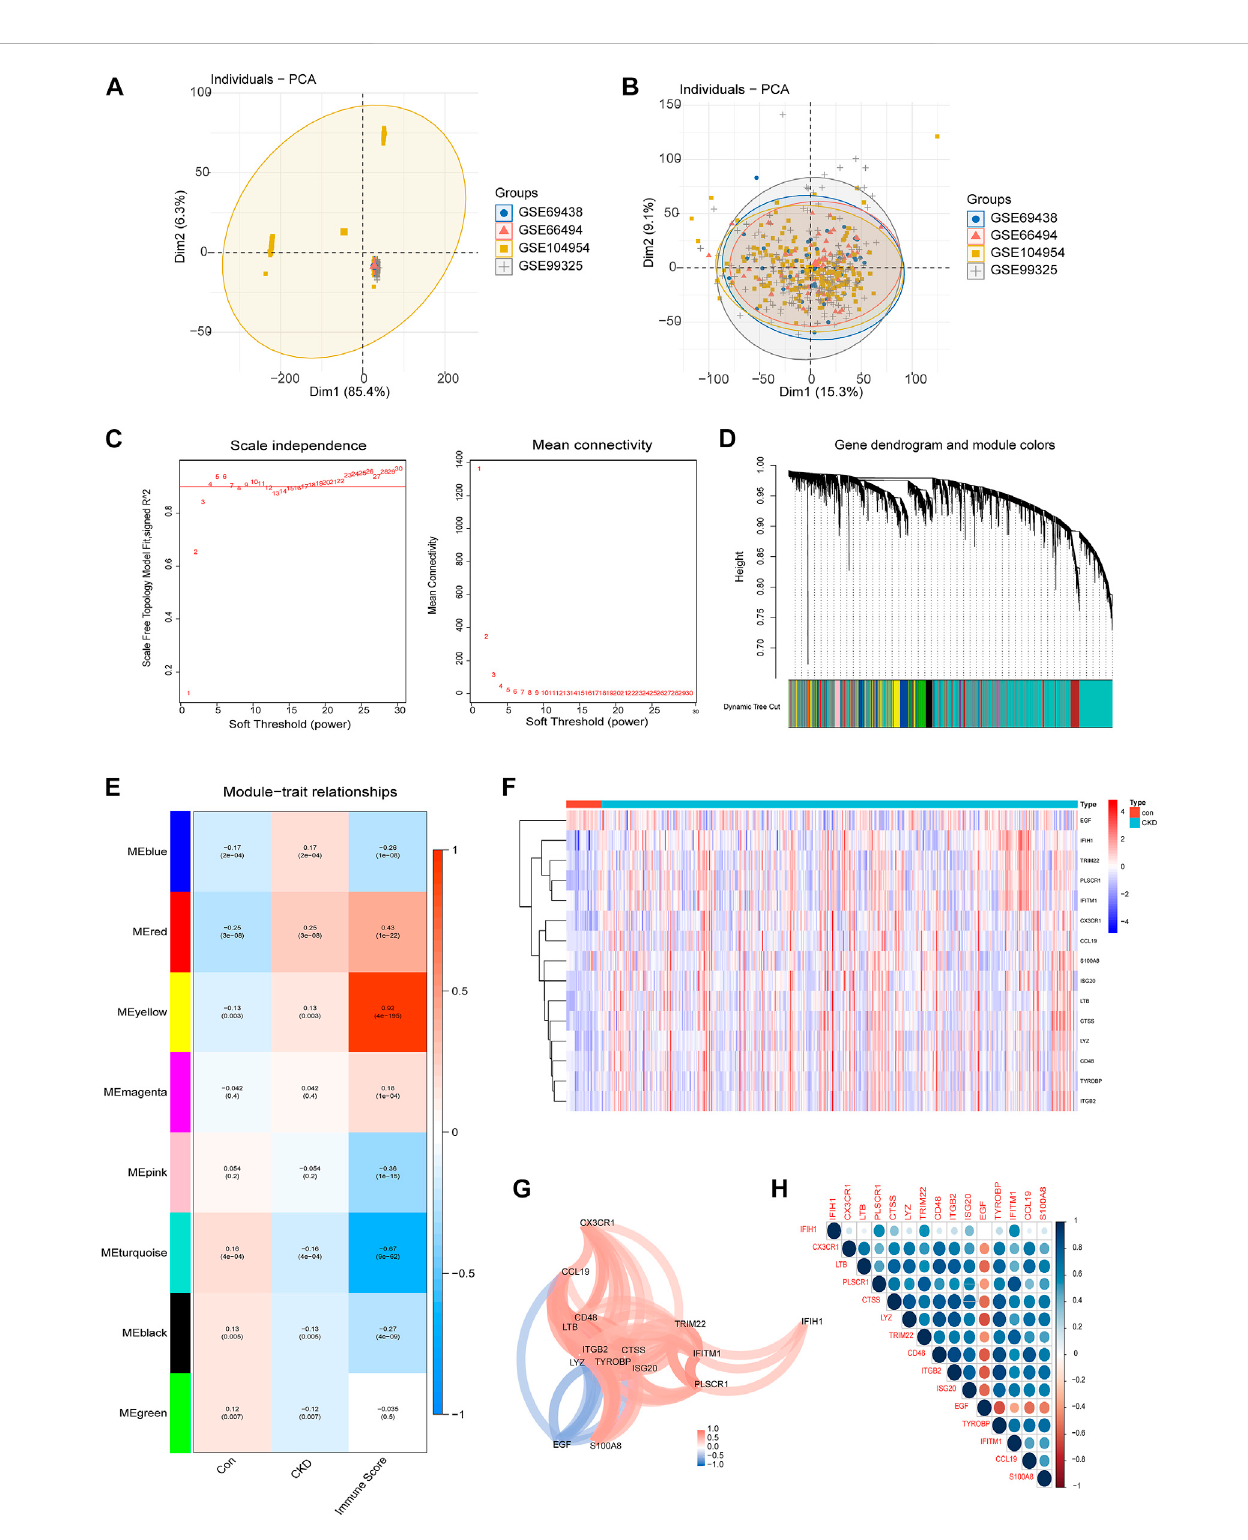
FIGURE 2 Identi fi cation of core IRGs in CKD. (A, B) PCA results of sample clustering before (A) and after (B) batch calibration. (C) Filtering of soft thresholds. (D) Cluster trees of co-expressing genes. (E) Division of gene modules, heat map of the relationship between building blocks and characteristics. (F) Representative heatmap of 15 differentially expressed IRGs. (G) Diagram of the gene relationship network for 15 IRGs with differential expression. (H) Representative correlation diagram of 15 differentially expressed IRGs. Blue is a positive correlation and red is a negative